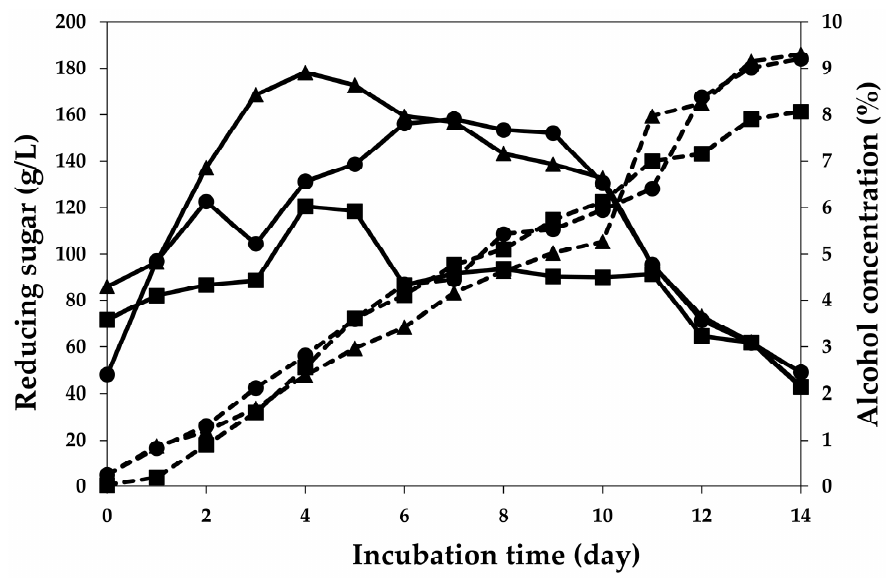
Figure 2. Reducing sugar (solid line) and alcohol contents (dash line) of plum wine during alcohol fermentation using S. cerevisiae var. burgundy ( • ), H. thailandica Zal1 ( (cid:4) ), and EC1118 ( (cid:78) ).